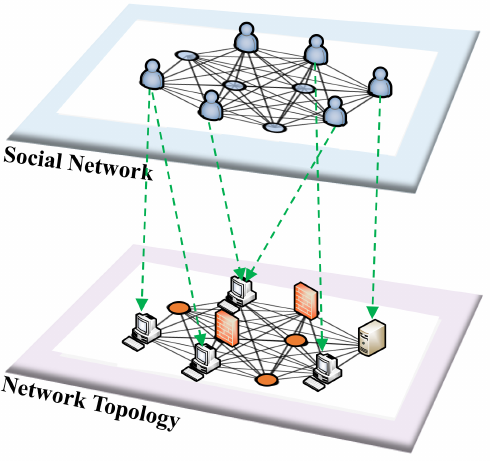
Figure 5. Relationship between social network and target network